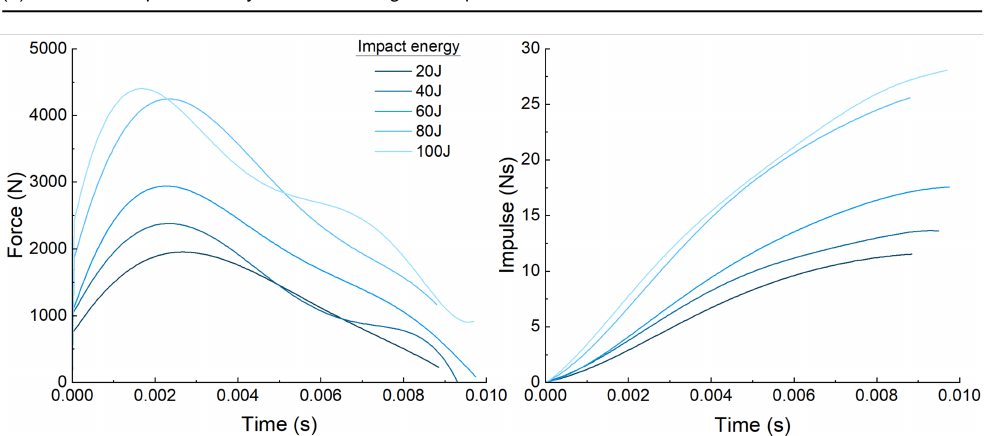
Figure 5. Results of the impact experiments showing ( a ) high-speed images of the impact sequence of hockey ball on mouthguard and ( b ) the force and impulse histories of the hockey ball–mouthguard impact tests for different impact